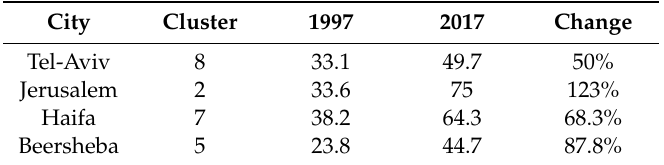
Table 6. Property tax rate per square meter change between 1997 and 2017.